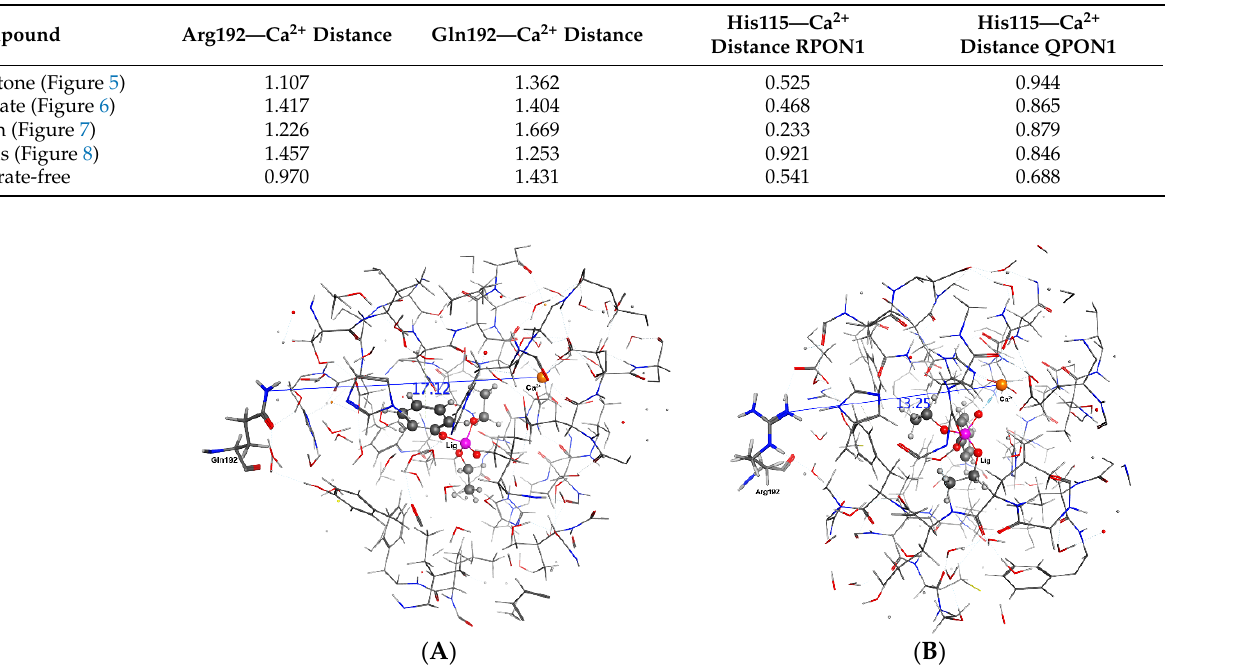
Figure 7. The distance between Glu192/Arg192 and Ca 2+ ion in the active site in the Paraoxon system after 20 ns. ( A ) is the QPON1. ( B ) is the RPON1 .